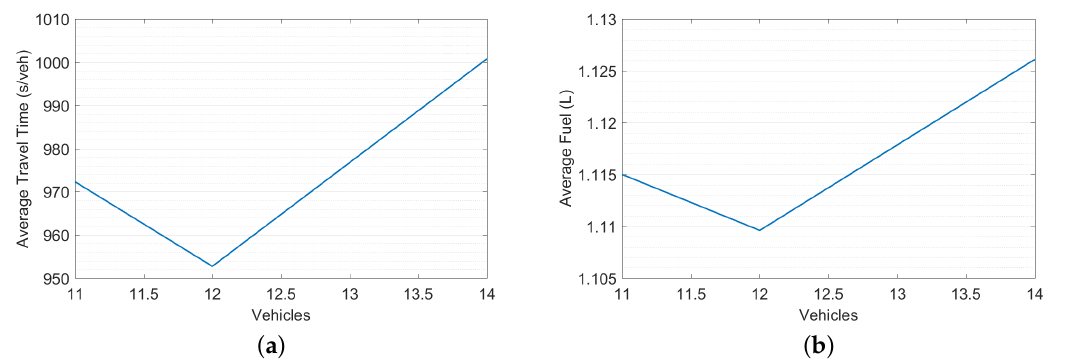
Figure 8. LA Sensitivity Analysis. ( a ) Average Travel Time. ( b ) Average Fuel